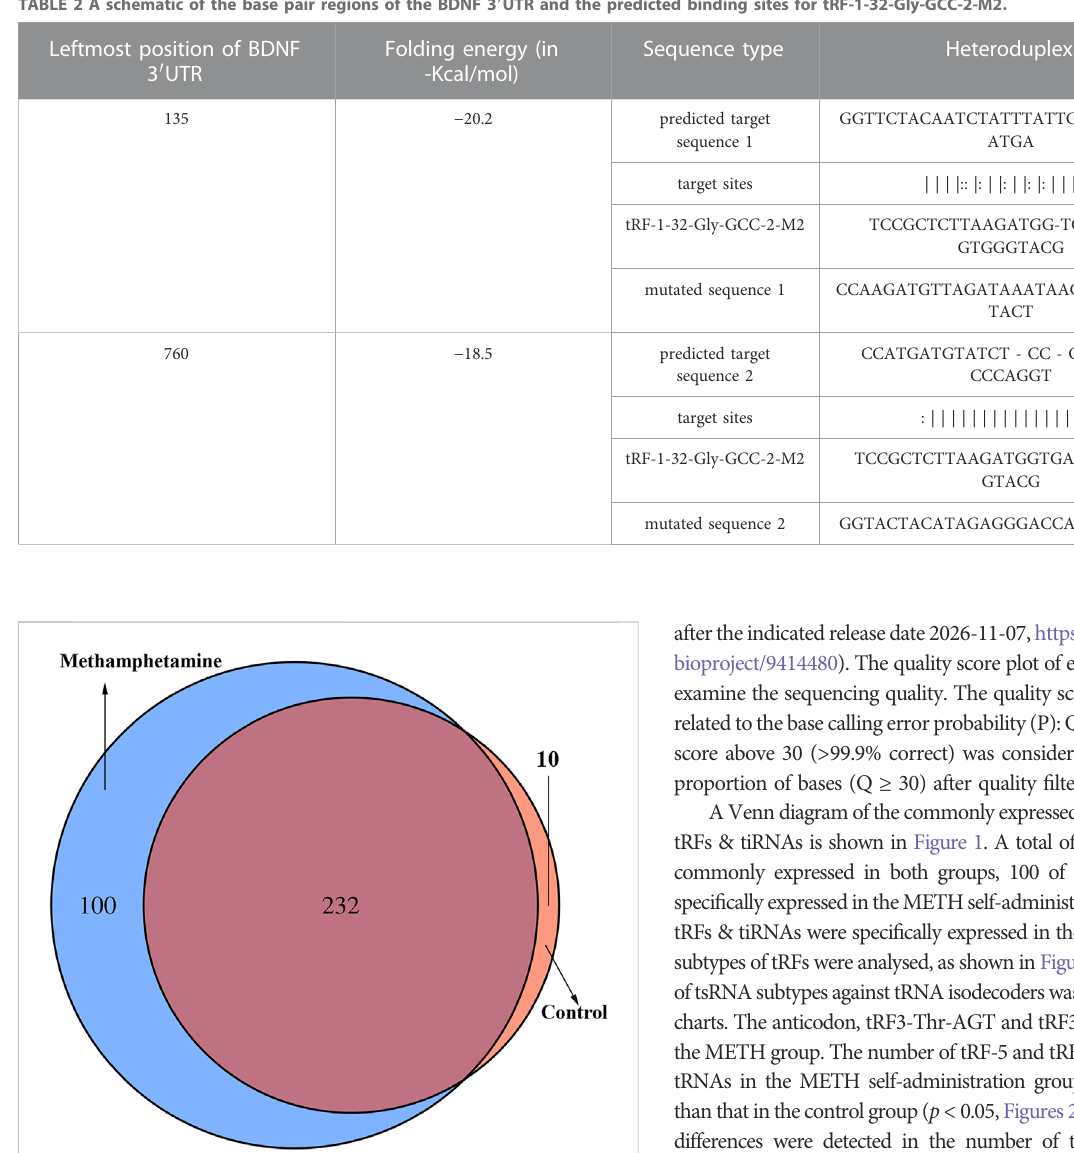
Venn plot to show the total number of identi fi ed tsRNAs in the NAc in methamphetamine self-administration and saline control rats.